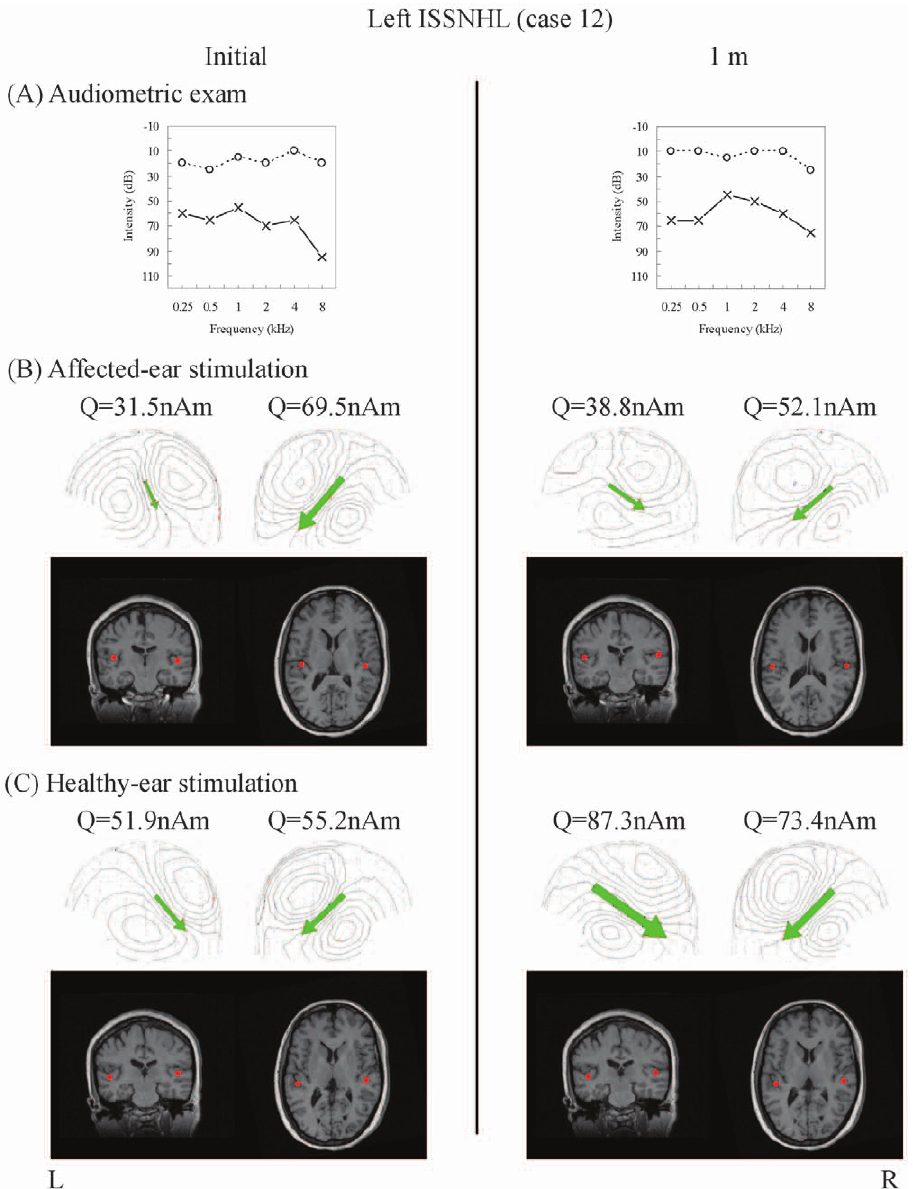
Figure 1. Temporal dynamics of neuromagnetic responses to monaural stimulation with reference to hearing status in unilateral ISSNHL patients. Patient 12 (female, left ISSNHL) was studied initially on the seventh day after onset. ( A ) PTAresultsofairconductionexam. The patient demonstrated a sensorineural hearing loss pattern in initial exam (left column) and had a hearing gain of less than the cut-off value for hearing improvement (10 dB; see method for definition) 1 month later (right column). Dashed and solid lines denote right and left ear threshold, respectively. ( B ) & ( C ) Neuromagneticfieldpatternsandsourcelocalizations. In initial MEG exam (left column), ECDs (green arrows) revealed a pattern of healthy-side dominance. In 1-month MEG exam (right column), the pattern became relatively symmetrical. Dipole sources (red dots) are localized at the auditory cortices of bilateral temporal lobes in patients’MRI images. MRI views are displayed according to neurological convention, i.e., subject’ right hemisphere is on the right side of the